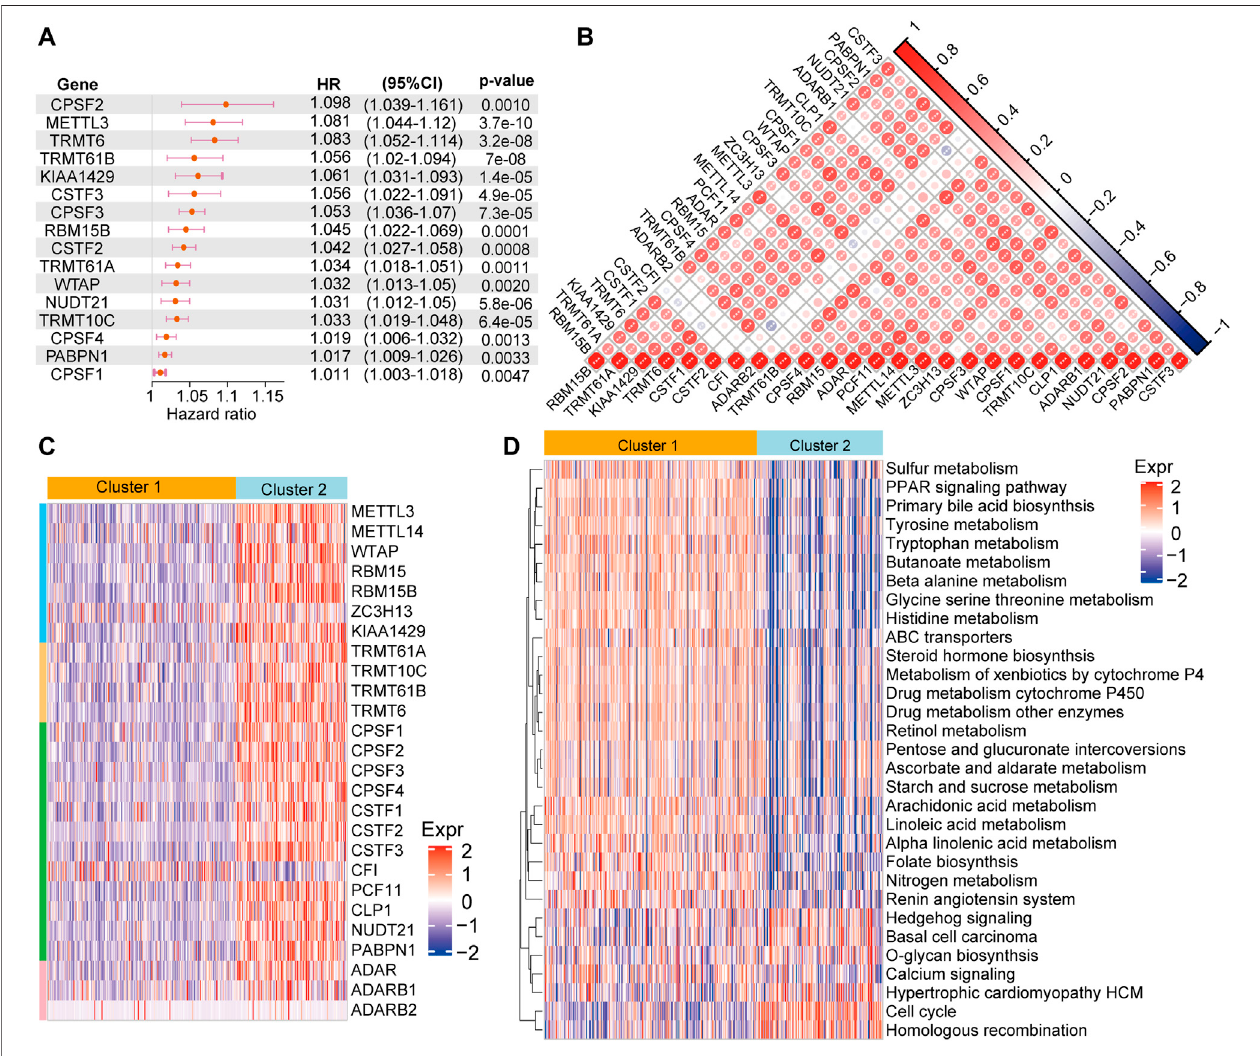
FIGURE 2 | RNA methylation modi fi cation pattern and related biological pathways (A) The univariate cox regression analysis shows that 16 of 26 regulators are associated with of patient prognosis in the TCGA-LIHC cohort (B) Heatmap of the Spearman ’ s correlation analysis presenting negative (blue) and a positive (red) correlation among the “ writers ” in HCC (C) Unsupervised cluster analysis of 26 “ writers ” in HCC. Blue represents low expression of “ writers ” genes; red represents high expression of these genes (D) GSVA enrichment analysis of KEGG pathway chances between cluster 1 and 2. Blue indicate not activated pathways, and red indicates activated